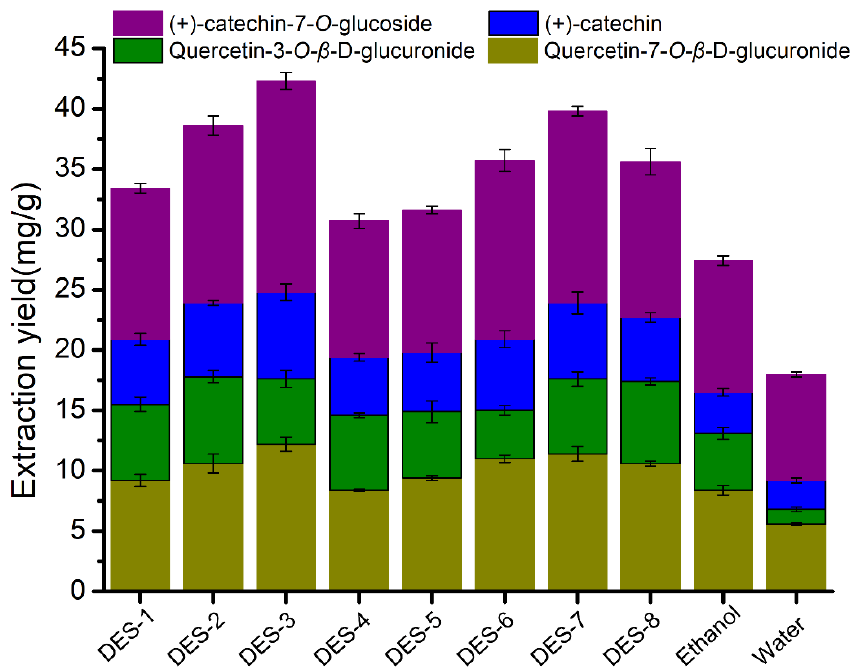
Figure 1. Extraction yield of flavonoids in 8 different 70 v / v % aqueous solutions of DES, ethanol, and water after ultrasonication-assisted extraction determined by HPLC analyses.